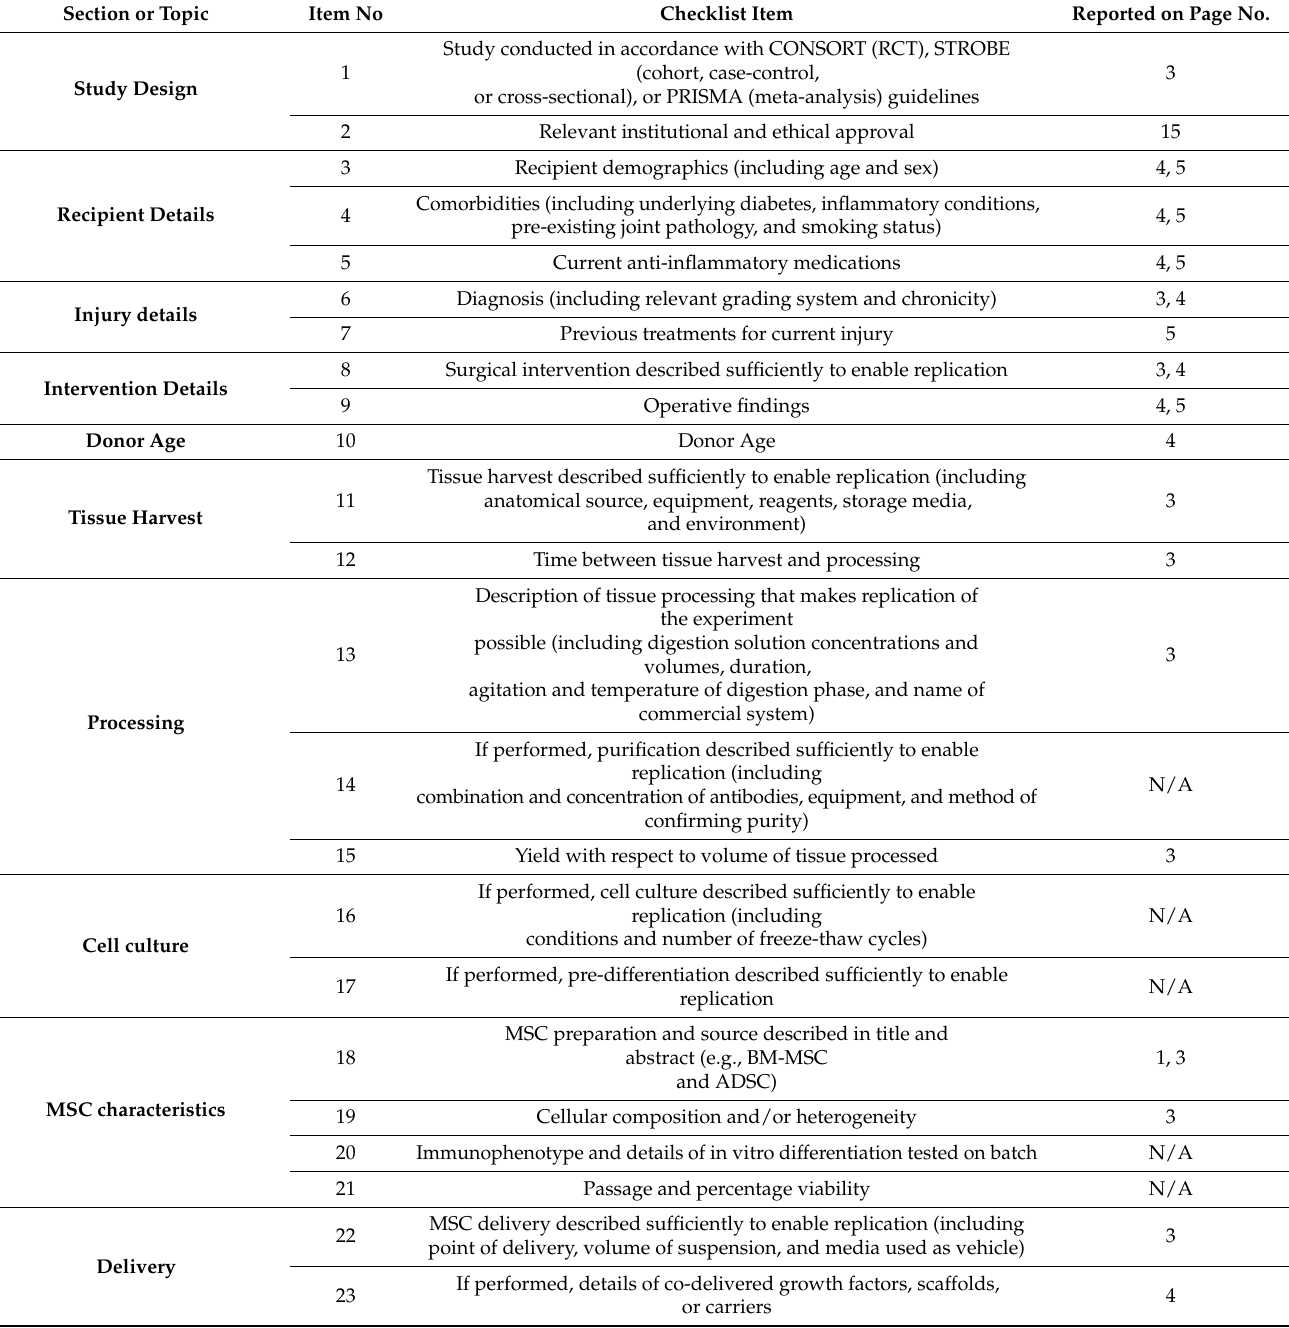
Table A1. Final Checklist of Minimum Reporting Requirements for Clinical Studies Evaluating MSCs That Reached Consensus Through the Delphi Process. This table has been included following guidelines published on the reporting of studies using BMC. Table reproduced from https://www. mibo-statement.org/ (accessed 10 January